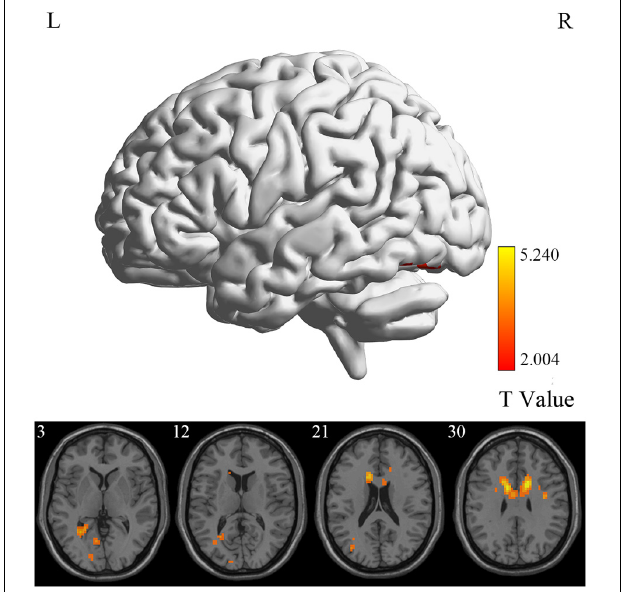
FIGURE 3 | fALFF differences between MCI reverters and HCs. fALFF, fractional amplitude of low-frequency fluctuation; HCs, healthy controls; L, left; MCI, mild cognitive impairment; R, right.